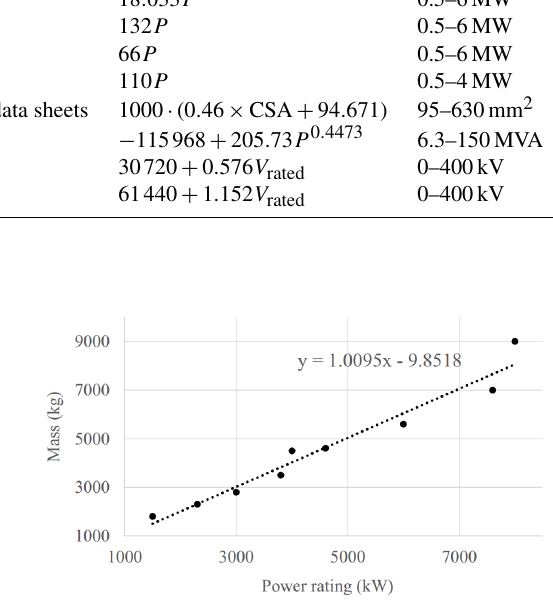
Figure 10. Scaling relationship for LV back-to-back